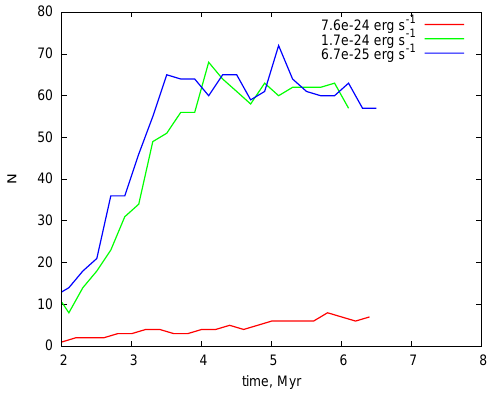
Figure 5. Number of cold and dense fragments in two bubbles collided about 0.2 Myr after all SNe have exploded in the bub- bles for different background heating rate (or background tem- perature) values: G = 7.6 × 10 −24 erg s −1 ( T = 10 4 K) – red b line, G = 1.7 × 10 −24 erg s −1 ( T = 3 × 10 3 K) – green line, b G = 6.7 × 10 −25 erg s −1 ( T b = 10 3 K) – blue line. The value